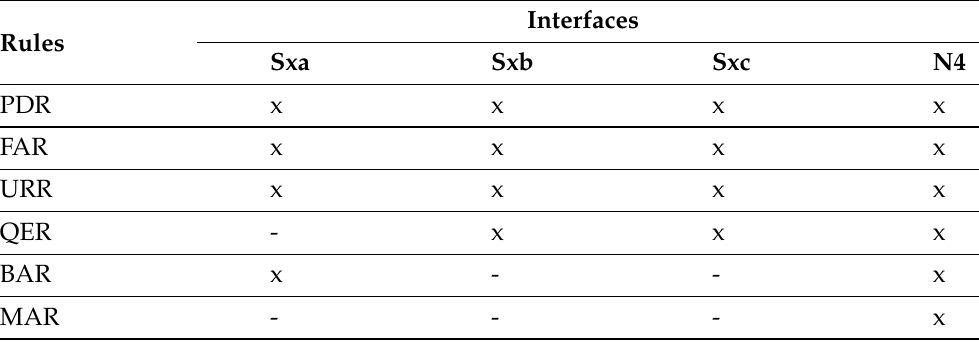
Table 1. Relation between the signaling interfaces (5G and LTE) between the CP and UP and the packet rules applied.